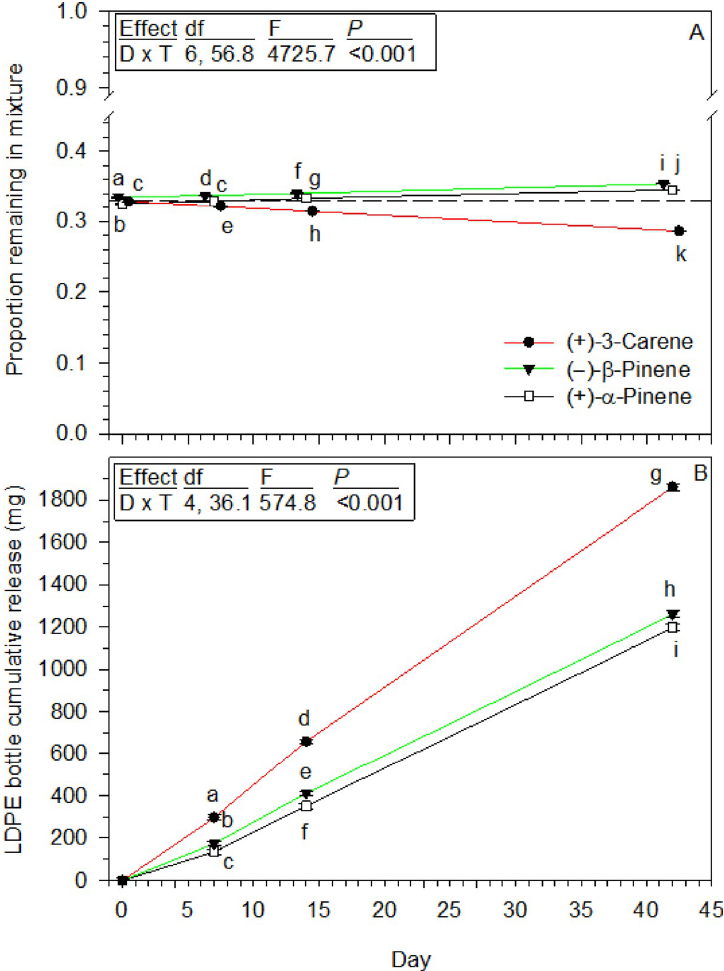
Fig 6. LDPE bottle release of a 1:1:1, (+)- α -pinene:( − )- β -pinene:(+)-3-carene, mixture in the laboratory (means ± 95% CIs). (A) Proportions of each monoterpene remaining in the mixture at 0, 7, 14, and 42 days ( n = 10). The dashed line is a reference = 0.333 proportion to help illustrate differences. (B) Cumulative release of each monoterpene at the same four days as A. In A and B the symbols with different letters are statistically different from one another at P < 0.001 for all comparisons. Note Y-axis break in graph A. Inserted boxes show ANOVA tables for each statistical analysis with effects abbreviated; D = Day, T = terpene.